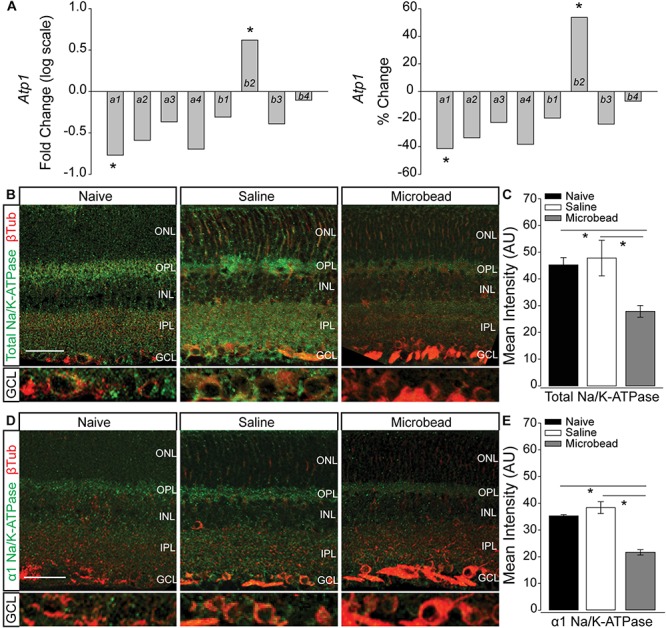
Elevated IOP decreases expression of total and α1 Na/K-ATPase in retina. (A) Box plots of fold change (log scale; left) and percent change (right) in expression of the Atp1 gene family between retina from saline- and microbead-injected mice, as determined by RNA sequencing. n(saline) = 5 retinas, n(microbead) = 5; ∗p < 0.005. (B) Representative confocal micrographs of total Na/K-ATPase (green) and β-Tubulin III (β-Tub; red) immunolabeling in retinal sections from naïve, saline-, and microbead-injected mice. Bottom panels of each image are a zoom of the ganglion cell layer (GCL). Scale bar = 40 μM. (C) Mean intensity of total Na/K-ATPase immunolabeling in retina from naïve, saline-injected, and microbead-injected mice. Asterisk indicates p < 0.05 and error bars represent SEM. n(naïve) = 8 retinal sections, n(saline) = 9, n(microbead) = 9 (from n = 4 eyes/condition). (D) Representative confocal micrographs of α1 Na/K-ATPase (green) and β-Tubulin III (β-Tub; red) immunolabeling in retinal sections from naïve, saline-, and microbead-injected mice. Bottom panels of each image are a zoom of the GCL. Scale bar = 40 μM. (E) Mean intensity of α1 Na/K-ATPase immunolabeling in retina sections from naïve, saline-injected, and microbead-injected mice. ∗p < 0.05 and error bars represent SEM. n(naïve) = 4 retinal sections, n(saline) = 8, n(microbead) = 5 (from n = 4 eyes/condition). ONL, outer nuclear layer, OPL, outer plexiform layer, INL, inner nuclear layer, IPL, inner plexiform layer, GCL, ganglion cell layer.